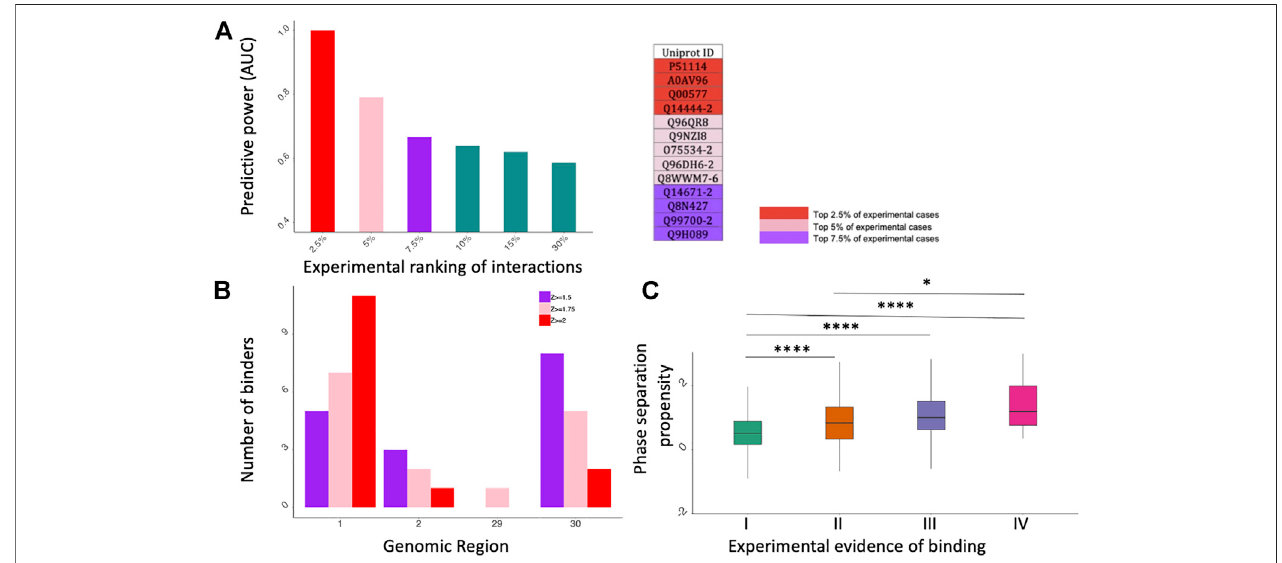
FIGURE2| catRAPID andcatGRANULEpredictions ofproteininteractions. (A) catRAPID performanceevaluation.Onthe X axiswereportdifferentportionsofthe experimental dataset ranked by fold change and on the Y axis there is the corresponding predictive power (Area Under the ROC Curve, AUC). On the right, we report a summary table showing the Uniprot IDs of top 2.5%, 5% and 7.5% experimental cases. (B) Distribution of speci fi c binders for Kamel et al. dataset (Kamel et al., 2021). ThemostcontactedSARS-CoV-2genomicregionscorrespondtothe5 ’ ( fi rstfragment)e3 ’ (30thfragment). (C) catGRANULEphaseseparationpropensityscores correlatewiththenumberofexperimentsreportingaproteintointeractwithSARS-CoV-2(Bolognesietal.,2016;Cid-Samperetal.,2018);* p -value < 0.05;**** p -value < 0.0001 (Wilcoxon rank sum test); I II, II, III and IV indicate proteins detected in 1,2,3 or 4 experiments,